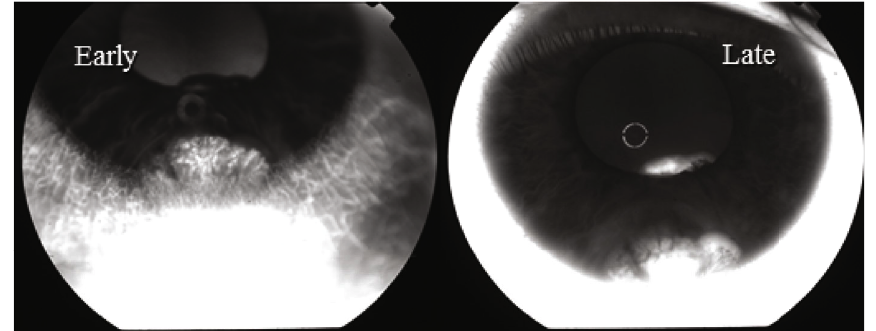
Figure 1: Fluorescein angiography demonstrating hyper fl uorescence in the early and late phases of the tumor on the iris from the 5 to 7 o ’ clock position and ciliary body (Zeiss). Part of the tumor is visible in the pupillary area posterior to the iris in the late-phase image.